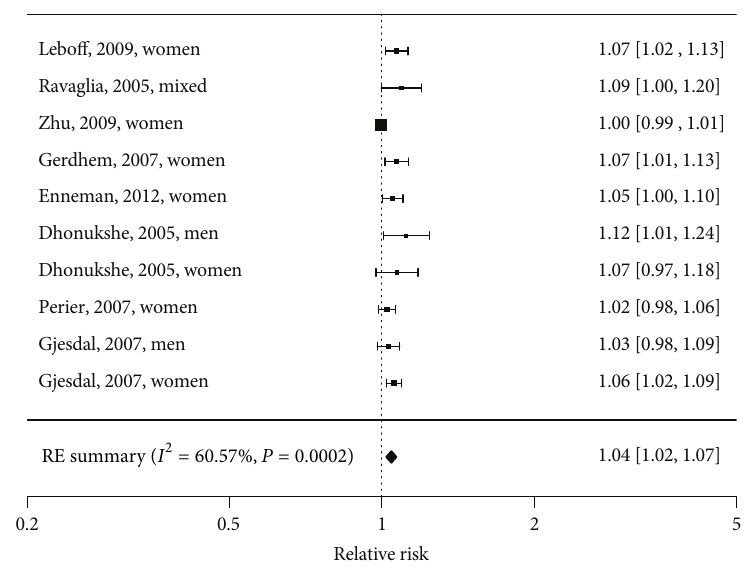
(3 studies; [24, 28, 29]) and total fractures (5 studies; [3, 26, 27, 30, 31]) were analyzed separately, the relation remained significant, 1.06 (95% CI: 1.03 to 1.08, 𝐼 2 = 0 %, 𝑃 = 0.72 )